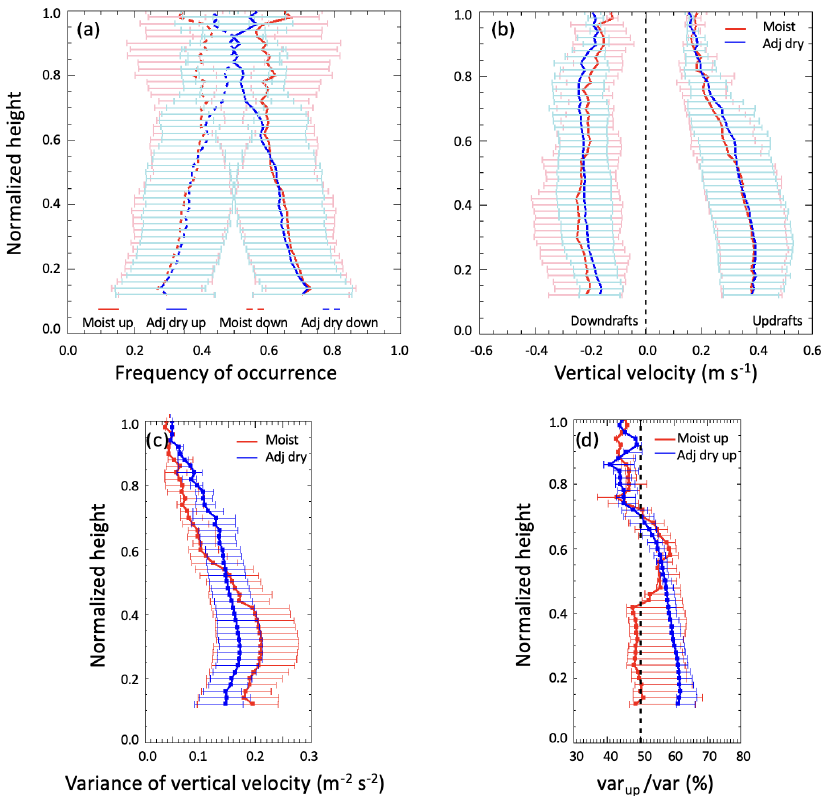
Figure 10. (a) Frequency of updrafts and downdrafts, (b) vertical velocity, (c) variance of vertical velocity in moist (red) and adjacent dry (blue) columns, and (d) contribution of updrafts to total variance in moist and dry columns. The contribution of downdrafts can be estimated as 100 − 100 · var up / var. The height is normalized to the cloud-base height.